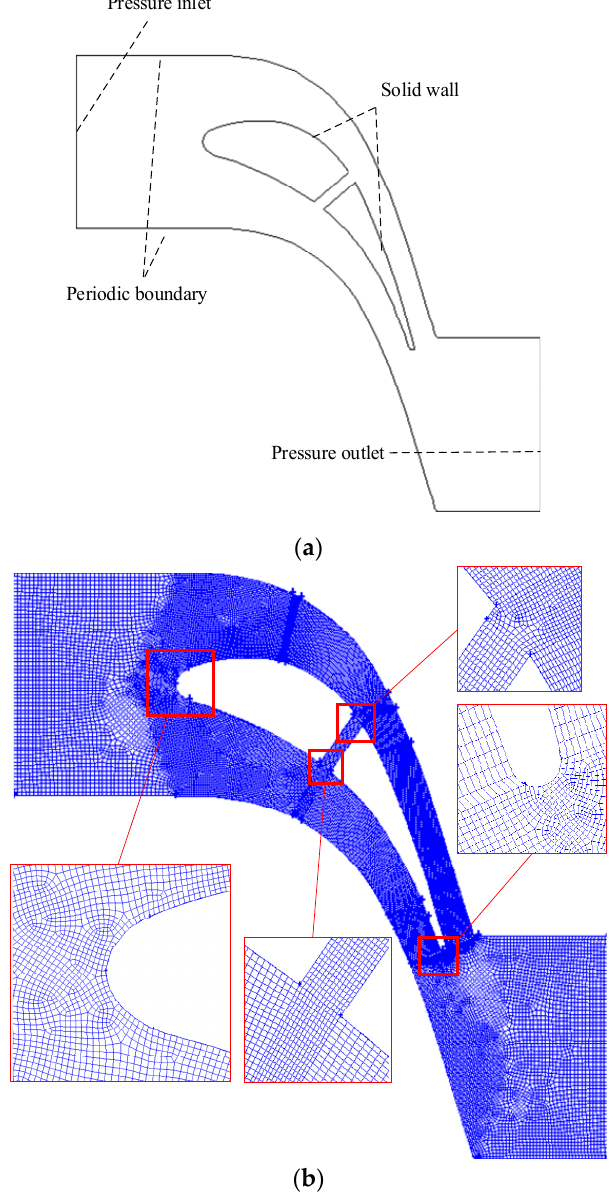
Figure 4. Setting of ( a ) boundary conditions and ( b ) mesh partition.